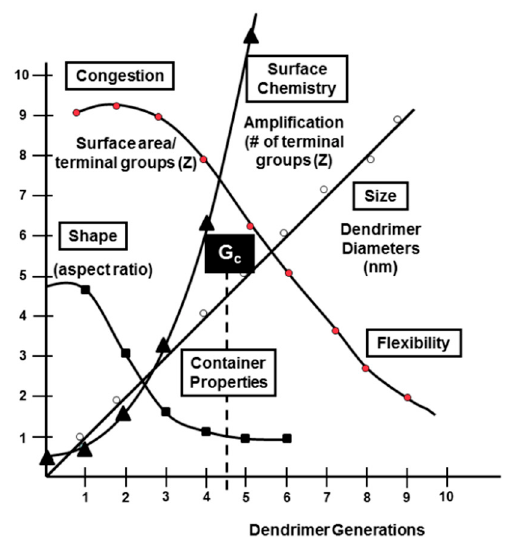
Figure 27. A comparison of emerging nano-periodic property patterns (i.e., endo-and exo-dendritic e ff ects) as a function of: size, surface chemistry amplification and congestion / flexibility. Reproduced by permission from [27]. Copyright 2012 The Royal Society of Chemistry (RSC) on behalf of the Centre